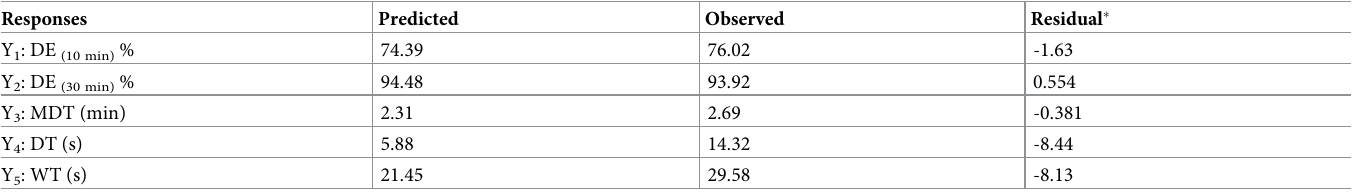
Table 4. Predicted and observed responses for the optimized DCN-ODT. Responses Predicted Observed Residual